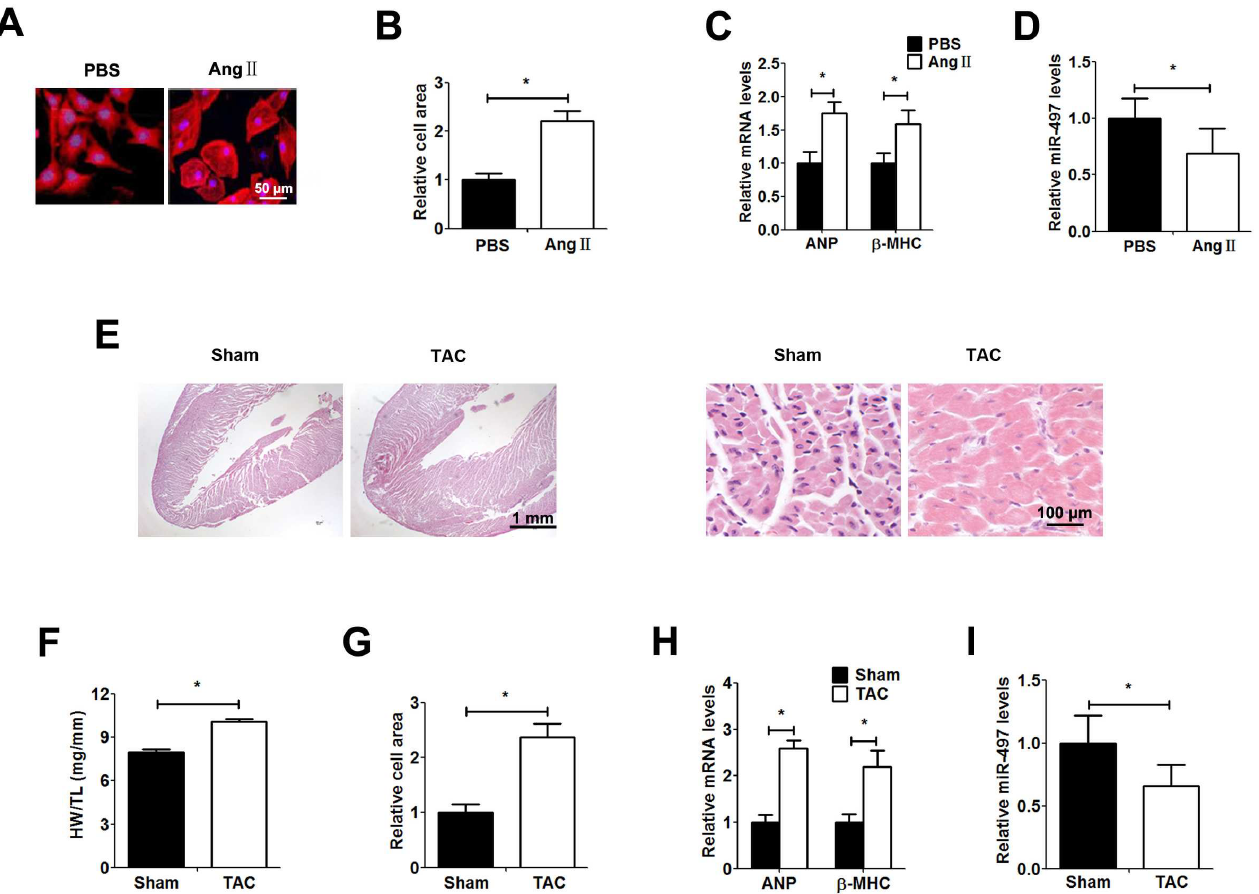
Fig 1. miR-497is down-regulated in hypertrophic cardiomyocytes. Establishment of hypertrophic cardiomyocytestreated with Ang II for 48h. a: Immunofluorescence assay of α -actinwas performed to identify cells. b: Relativecell area of cardiomyocytes detected by randomly measuring 10 cells from each section. c: ANP and β -MHC mRNA expressionmeasured by qRT-PCR. d: miR-497determinedby qRT-PCR. e: Establishment of a mouse model of TAC-induced hypertrophy and histological analysisof hearts from different groupsusing H&E staining. f: The ratio of heart weight to tibial length. g: Relativecell area of cardiomyocytes detected by randomly measuring 10 cells from each section. h: ANP and β -MHC mRNA expressionmeasuredby qRT-PCR assay. i: miR-497 determined by qRT-PCR. Data are presented as the mean ± SD; * , P < 0.05, n =